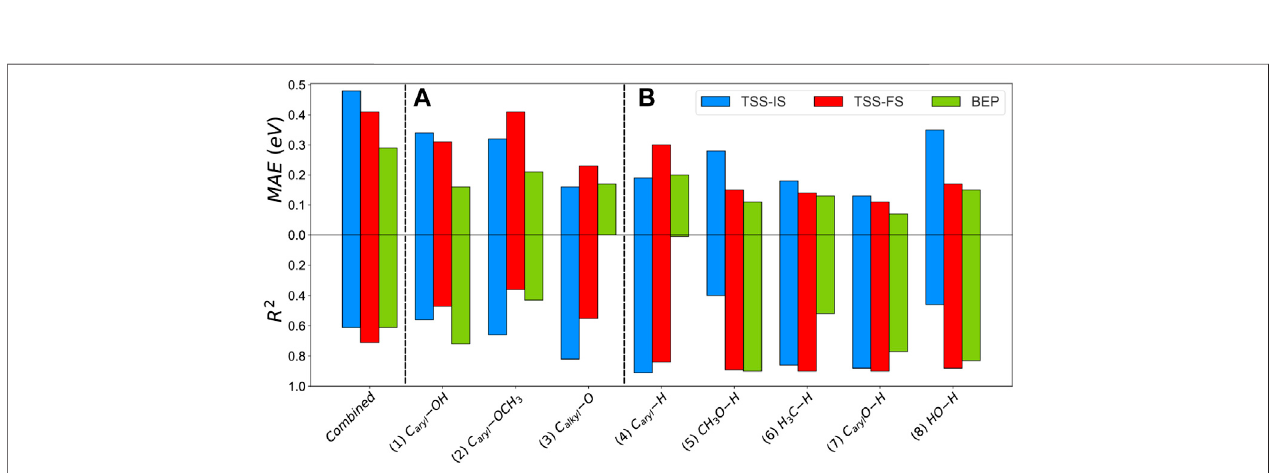
FIGURE 7 | Mean absolute error (MAE) and R 2 of the 1) combined, 2) scission of group (A) and 3) hydrogenation in group (B) for the TSS-IS, TSS-FS, and BEP relationships.